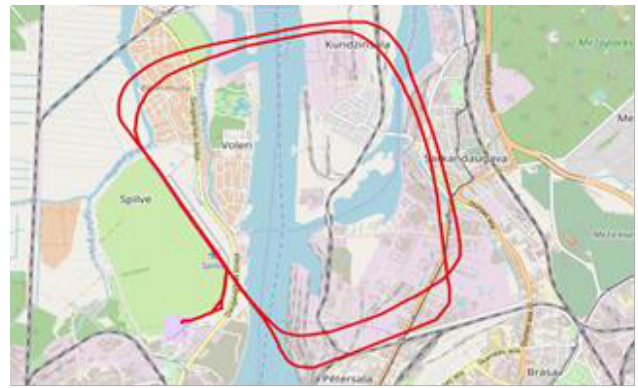
Fig. 2. Visualized GPS coordinates of the horizontal flight